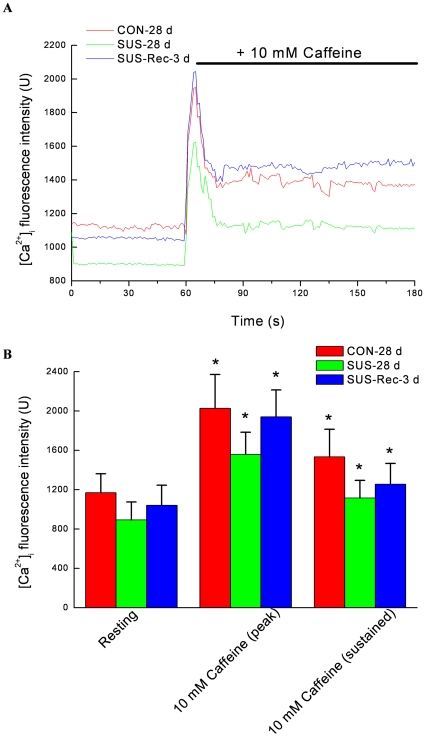
Caffeine elicits the increases of intracellular Ca2+ fluorescence intensity in small mesenteric VSMCs isolated from CON-28 d, SUS-28 d, and SUS+Rec-3 d rats.(A) Representative dot graph of Fluo-3/AM fluorescence recorded showed the typical transient increases of intracellular Ca2+ fluorescence intensity evoked by 10 mM caffeine. Caffeine was present at times shown by the horizontal bar. (B) Summarized data indicated the average changes of the intracellular Ca2+ fluorescence intensity before and during the application of caffeine. Values are means ± SE with the number of cells recorded in parentheses. CON-28 d: 28-day simultaneous control rats, SUS-28 d: 28-day tail-suspended rats, SUS+Rec-3 d: tail-suspended rats submitted to a recovery period of 3 days at the end of 28-day suspension. *P<0.05 as compared with their controls by t-test, respectively.